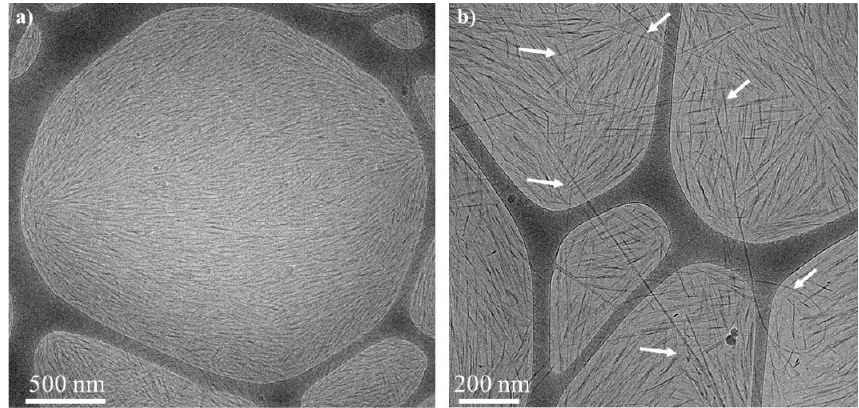
Figure 4. Cryo-TEM images of the N* phase of CNC–BrijS20–SWNTCH dispersions ( a ), ( b ) at two different magnifications. The arrows in ( b ) point to the contour line of the SWNTCH.